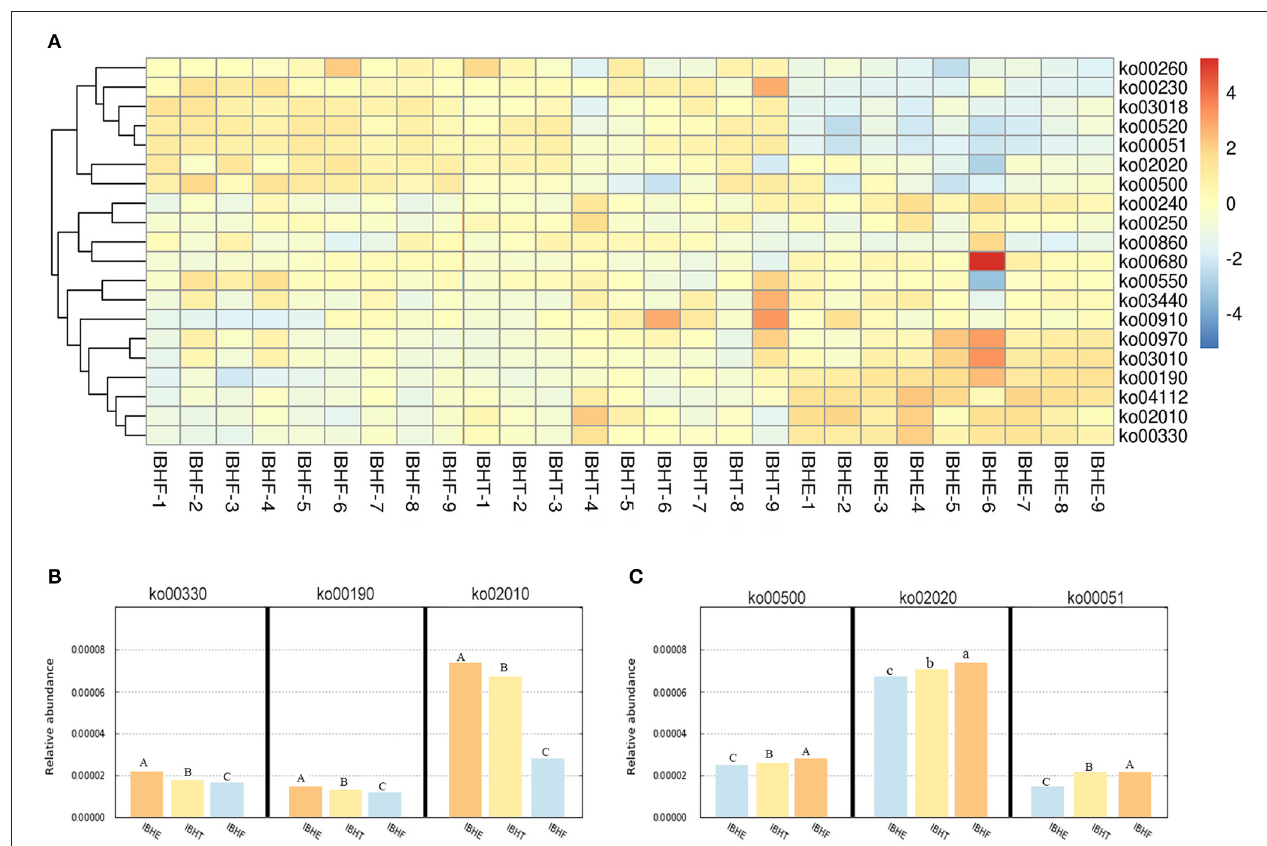
FIGURE 7 | (A) The heatmap of functional prediction of enriched metabolic pathways (ko) of OTUs in different growth periods. The color gradient of heatmap was from red to yellow to blue, which indicates that the metabolic pathway abundance predicted by OTUs in each sample decreased gradually. The redder the color, the more bacteria performed this function. The bluer the color, the lesser bacteria performed this function. IBHE, IBHT, and IBHF refer to “ISA Brown Hens-8 weeks,” “ISA Brown Hens-20 weeks,” and “ISA Brown Hens-50 weeks,” respectively. (B) The abundance histograms of significantly increased metabolic pathways of OTUs from 8 to 20 and 50 weeks. (C) The abundance histograms of significantly reduced metabolic pathways of OTUs from 8 to 20 and 50 weeks. Metabolic pathways with different superscript letters mean significant differences ( P < 0.05) between groups, and different superscript letters mean extremely significant differences ( P < 0.01).